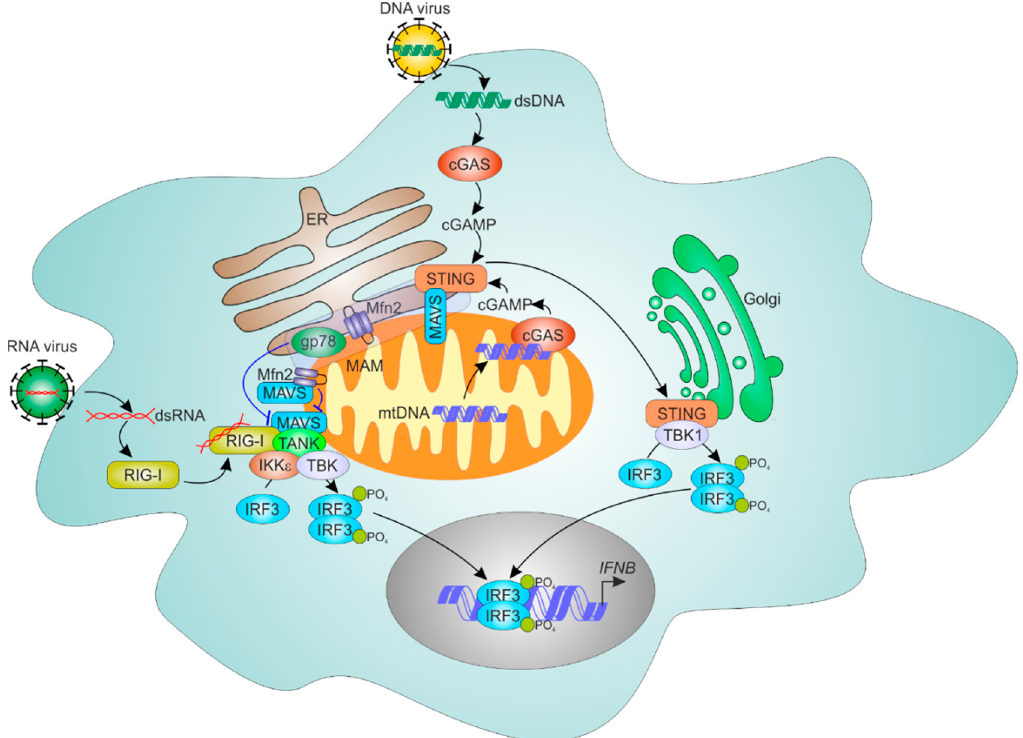
Figure 3. Communication of ER and mitochondrial in sensing cytosolic nucleic acids. The response to RNA viruses is orchestrated by the sensor retinoic acid inducible gene I (RIG-I), which upon dsRNA recognition translocates to mitochondria- and the MAM-located adaptor MAVS to activate the interferon regulatory factor 3 (IRF3) transcription factor. MAVS may be negatively regulated by their interaction with Mfn2 and Gp78. Sensing of cytosolic DNA involves activation of the cyclic GMP-AMP (cGAMP) synthase (cGAS)-stimulator of interferon genes (STING) cascade, whereas activated STING translocates from the ER to Golgi to activate IRF3. The cross-talk between DNA and RNA sensing may involve direct interaction of STING and MAVS. cGAS may also sense mtDNA following mitochondrial damage by translocating to mitochondria.